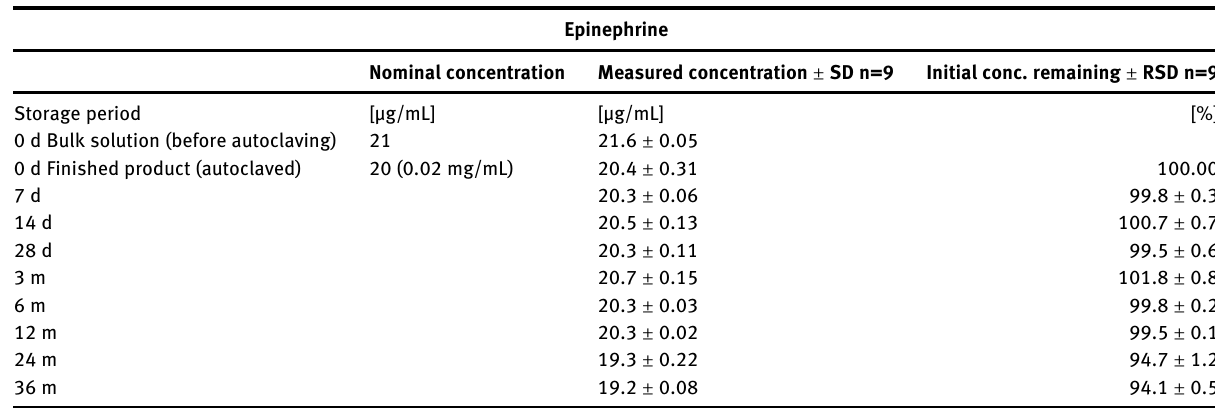
Table  : Stability of Epinephrine  .  mg/mL injection solution in  mL amber glass vials stored at  –  ° C. Concentration expressed as mean ± relative standard deviation of triplicate assays of three test solutions (n=  ). Drug concentrations of the fi nished product in samples taken at time zero were designated as 